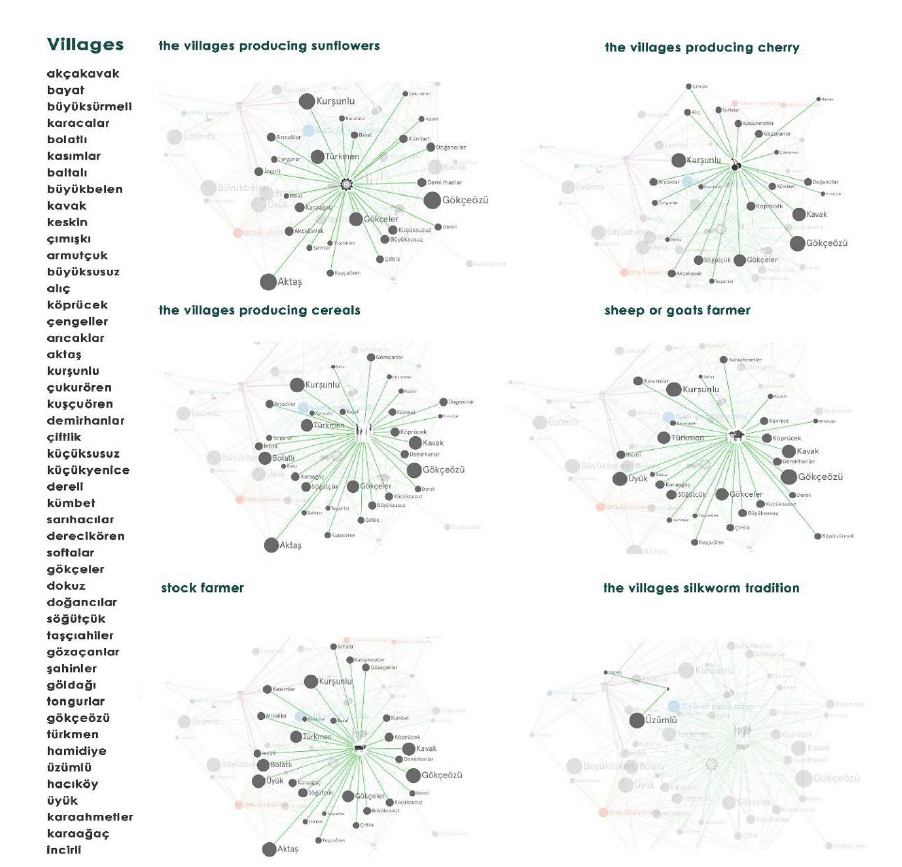
Figure 25 The agriculture and animal husbandry potential of Gölpazarı villages (source: arranged by Keep Your Village Alive